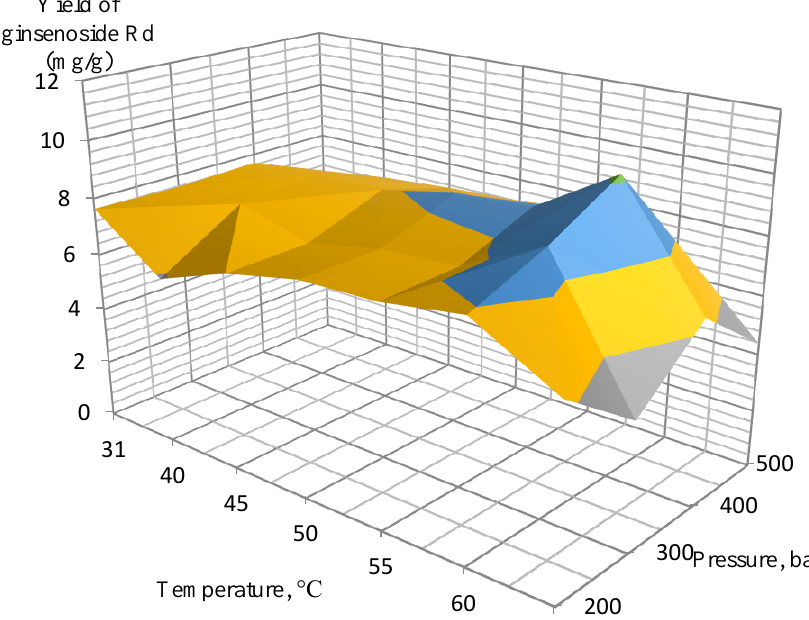
Figure 3. Orthogonal projection representing the results of extraction of ginsenoside Rd at 200 to 500 bar and 3.4% EtOH